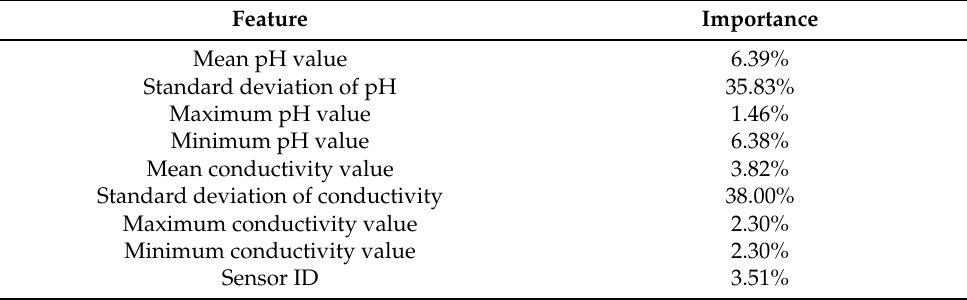
Table 3. Feature importance—pollutant detection and